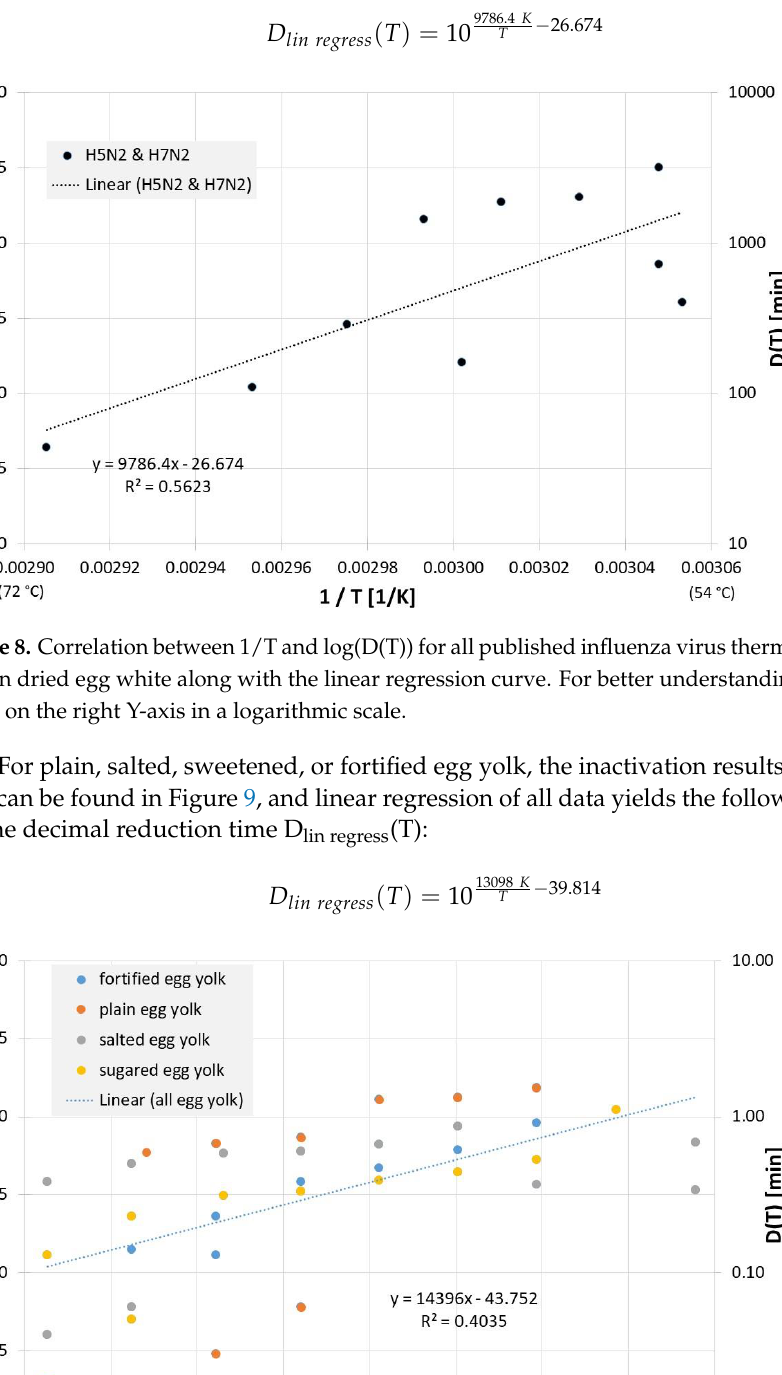
Figure 10. Correlation between 1/T and log(D(T)) for all published influenza virus thermal inactiva- tion data in in fat free egg and egg substitutes along with the linear regression curve. For better understanding, D(T) is also given on the right Y-axis in a logarithmic scale.